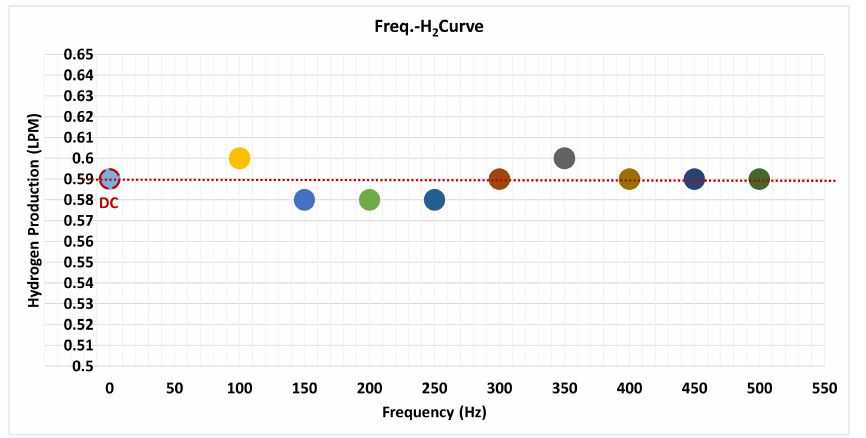
Figure 7. Frequency vs. H 2 production characteristic curve of electrolyzer according to pulse- frequency